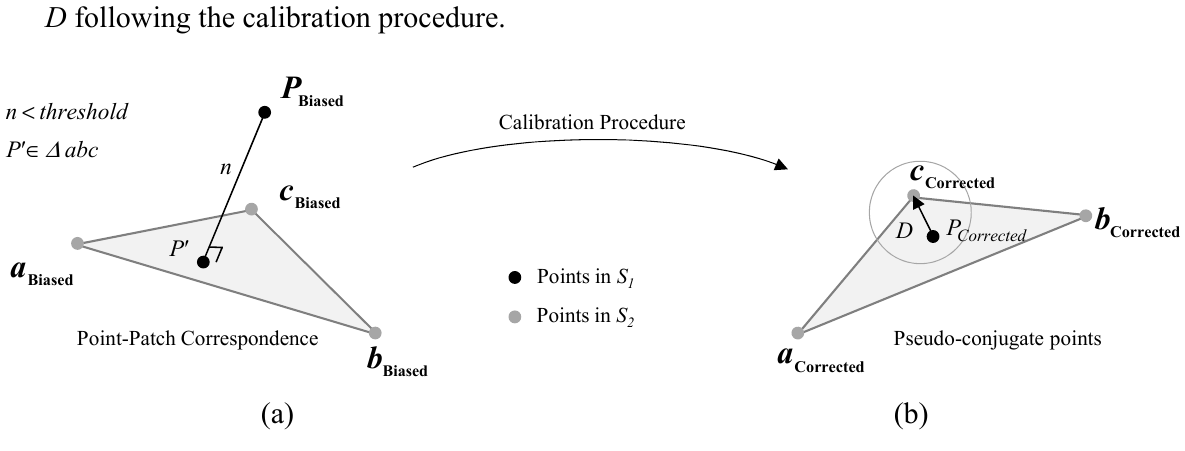
Figure 2. ( a ) Point-patch correspondence procedure and ( b ) the additional unknown vector D following the calibration